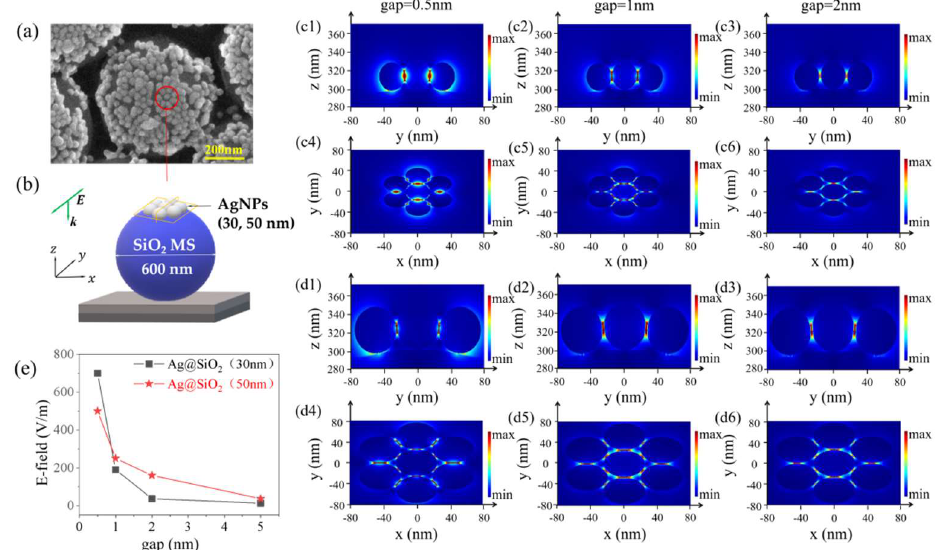
Figure 4. ( a ) SEM of Ag@SiO 2 ; ( b ) simulation model: electromagnetic field distribution of Ag@SiO 2 substrate; ( c ) electromagnetic field distribution of Ag@SiO 2 –30 with different gaps; ( d ) electromag- netic field distribution of Ag@SiO 2 –50 with different gaps; ( e ) the relationship between electric field intensity and gap of AgNPs.